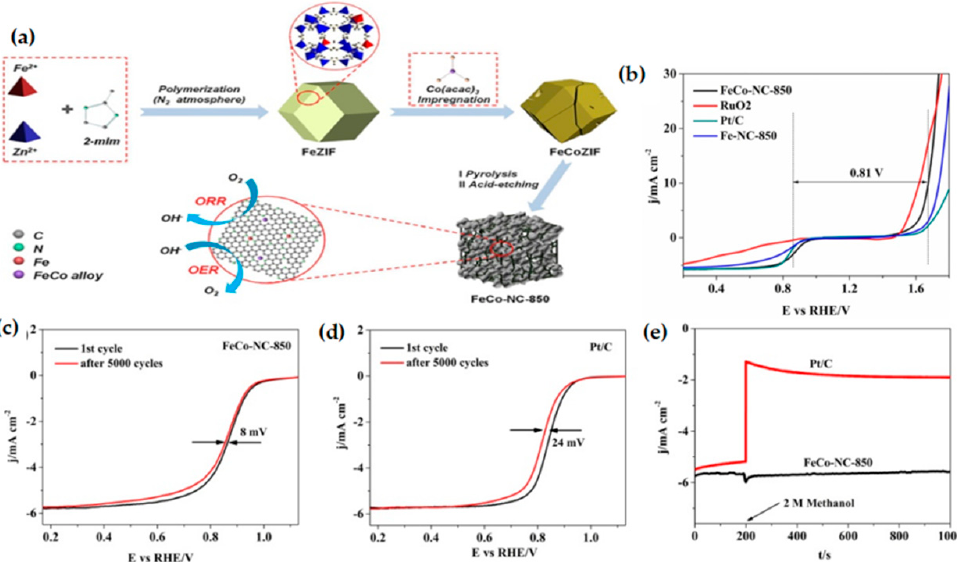
Figure 10. ( a ) Schematic illustration for the synthesis of FeCo-NC-850; ( b ) the overall LSV curves of FeCo-NC-850, Fe-NC-850, RuO 2 , and Pt/C at 1600 rpm in 0.1 M KOH. LSV curves of ( c ) FeCo-NC-850 and ( d ) Pt/C before and after 5000 cycles; ( e ) The i–t chronoamperometric response of FeCo-NC-850 and Pt/C with addition of 2 M methanol. All the catalysts were measured in 0.1 M KOH solution. Copyright 2019 Elsevier B.V. Allrightsreserve [107].